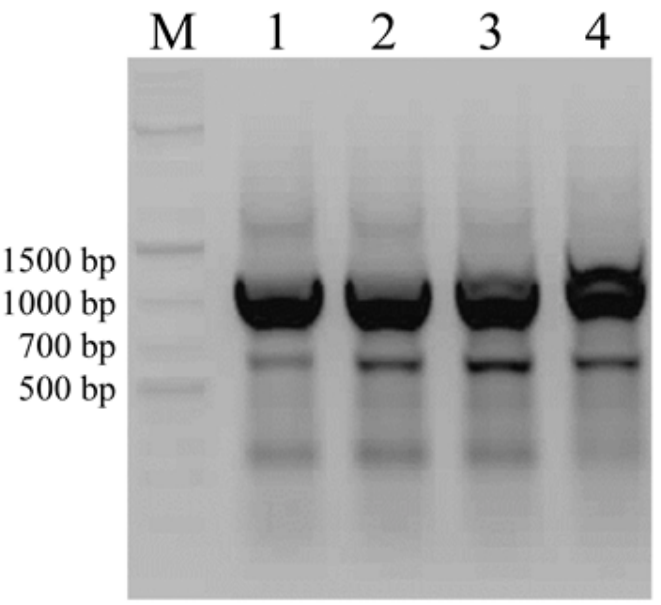
Figure 3. PCR amplification with degenerate primers (As1-F and Ts2-R) for Sphingomonas sp. strain S11 at an annealing temperature of 51 °C (line 1), 48.4 °C (line 2), 45.7 °C (line 3) and 43.1 °C (line 4). M - GeneRuler 1kb Plus DNA Ladder (Thermo Scientific, Waltham, MA, USA).